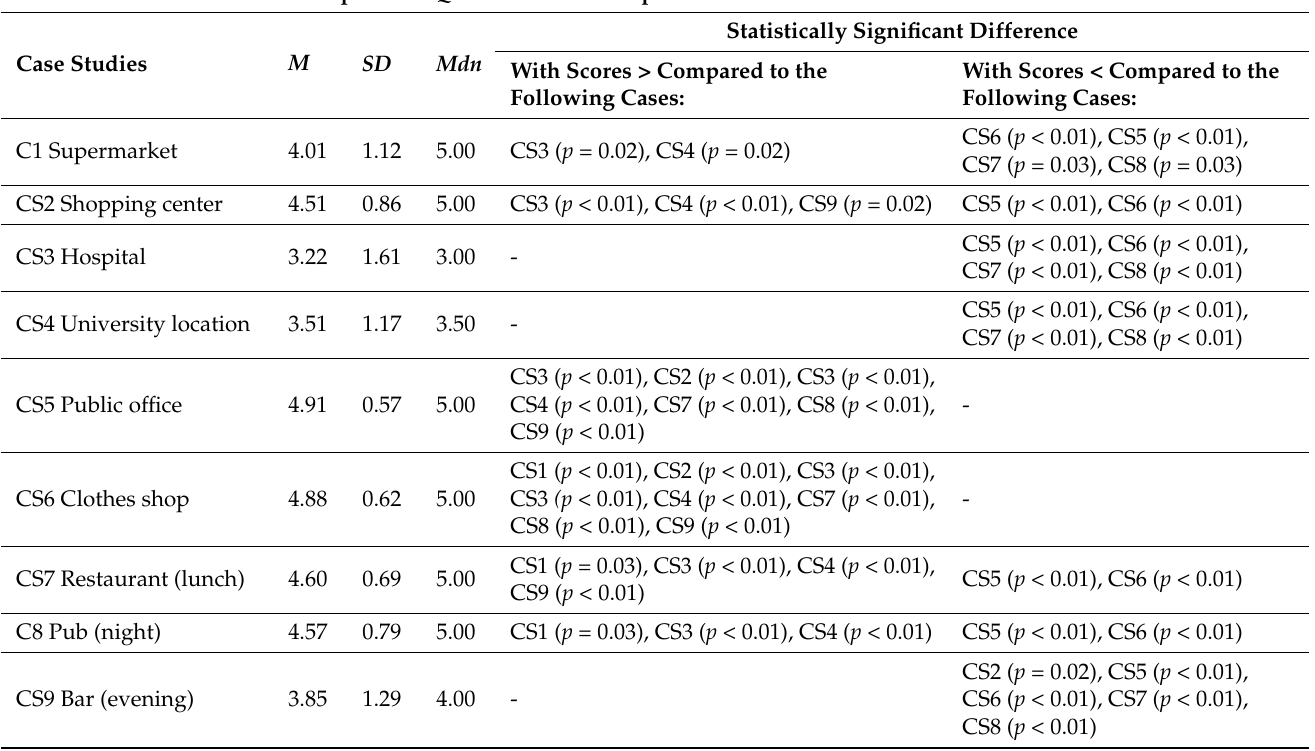
Table A14. Table shows the statistically significant differences ( p (BH)) that emerged from the comparison of item 11 in the different case studies (CS1–CS9). In the table is also reported the mean ( M ), the standard deviation ( SD ) and the median ( Mdn ). Own processing.